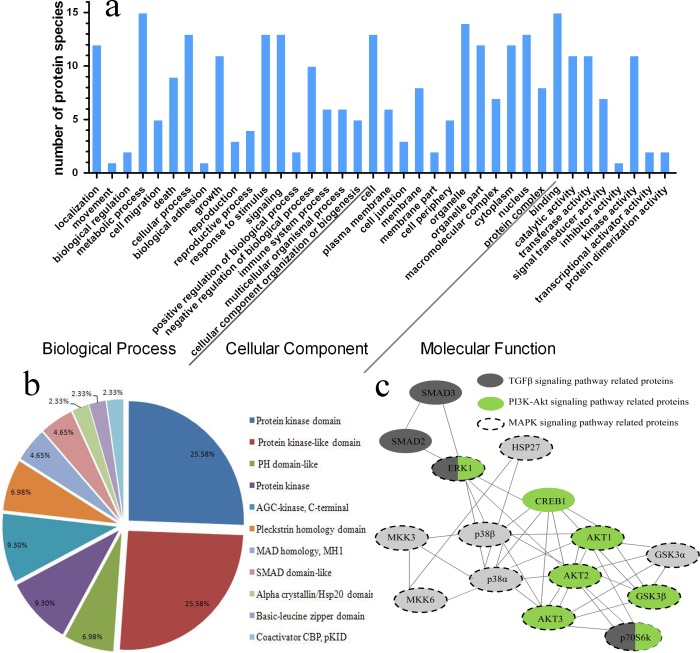
Functional classification and protein–protein interaction of the differentially expressed proteins in GDF11-treated C17.2 cells and control.(A) According to GO annotation, the differentially expressed proteins between GDF11-treated cells and control were mainly clustered into 38 functional groups, including 18 biological processes, 12 cellular components, and eight molecular functions. (B) Protein domain categories of the differentially expressed proteins were annotated by InterProScan. (C) The protein–protein interaction network of the differentially expressed proteins was analyzed by KEGG) database.